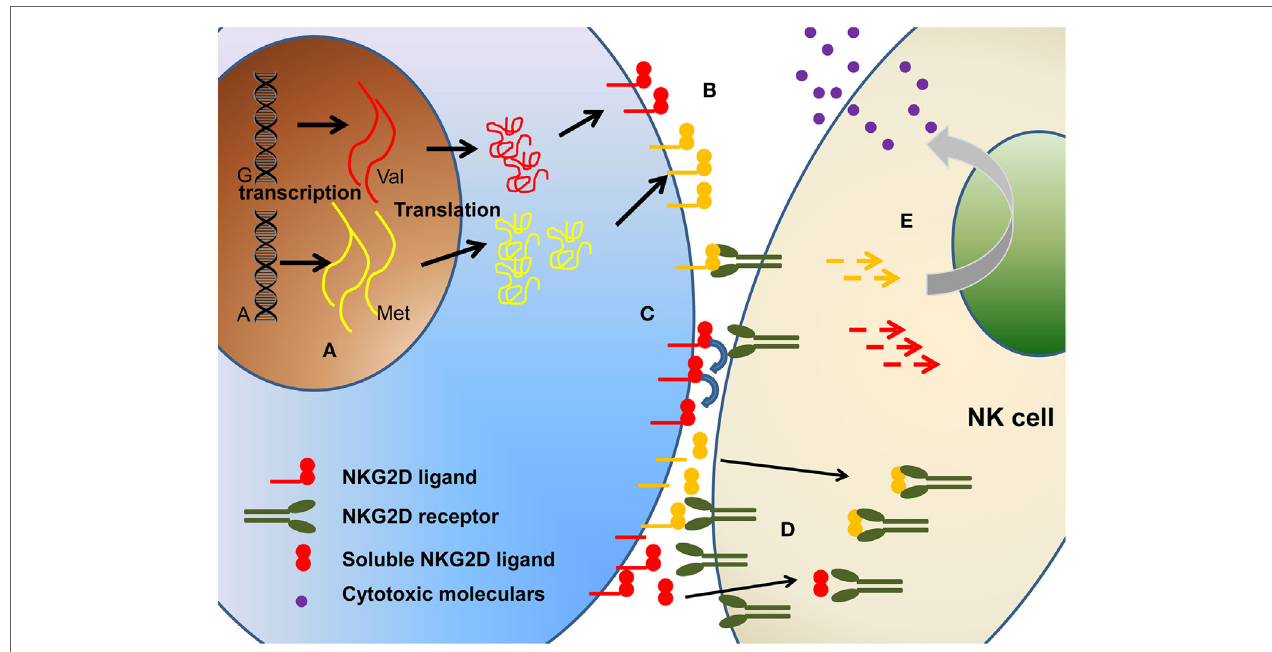
FiGURe 2 | The polymorphism of NKG2D ligands will affect the biological function of NKG2D ligands in multiple levels, including (A) different transcription, (B) different expression level on cell surface, (C) different binding affinity, (D) different soluble ligands shedding. Collectively, these will ultimately affect the (e) downstream signaling and cytotoxicity